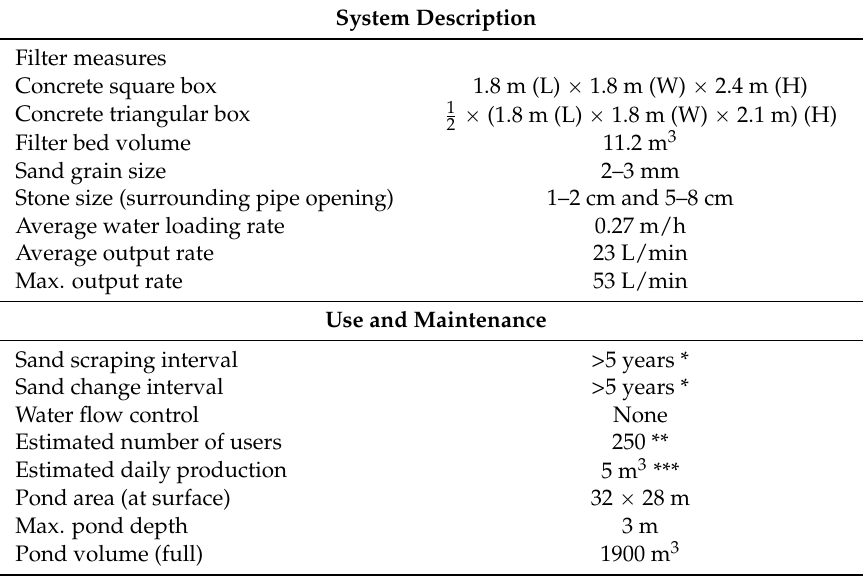
Table 1. Characteristics of filter construction, use and